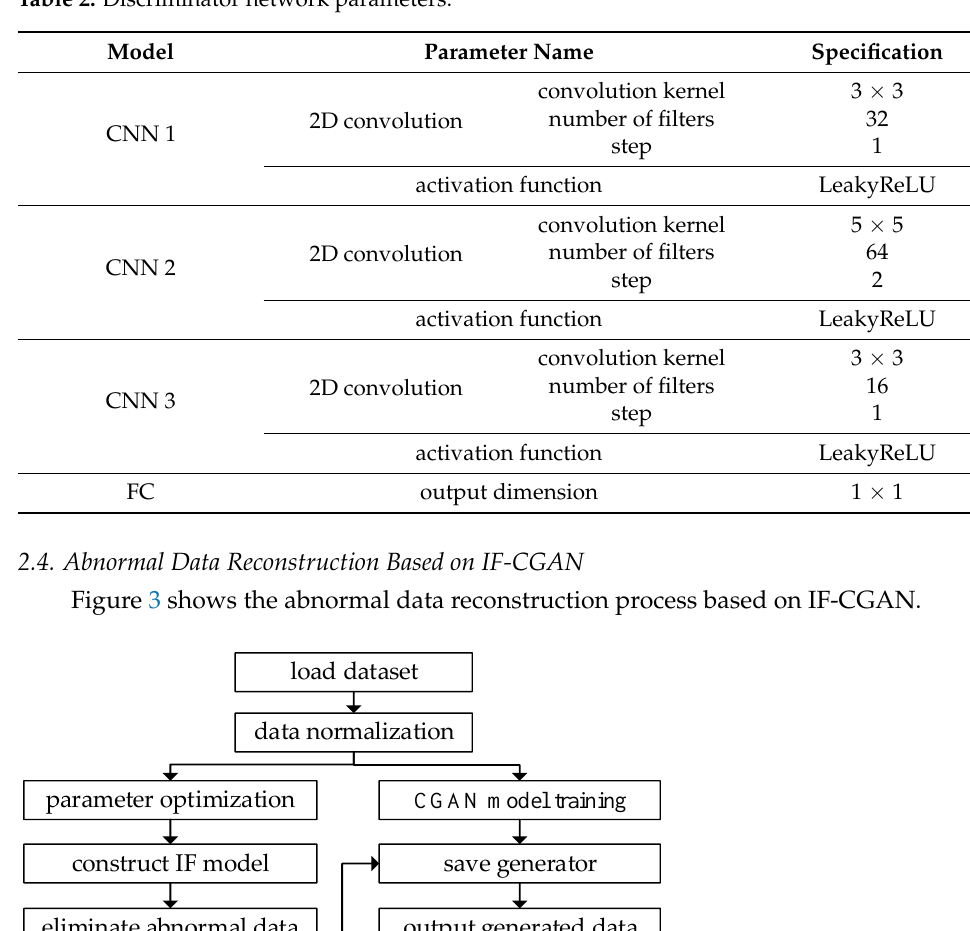
Table 2. Discriminator network parameters.